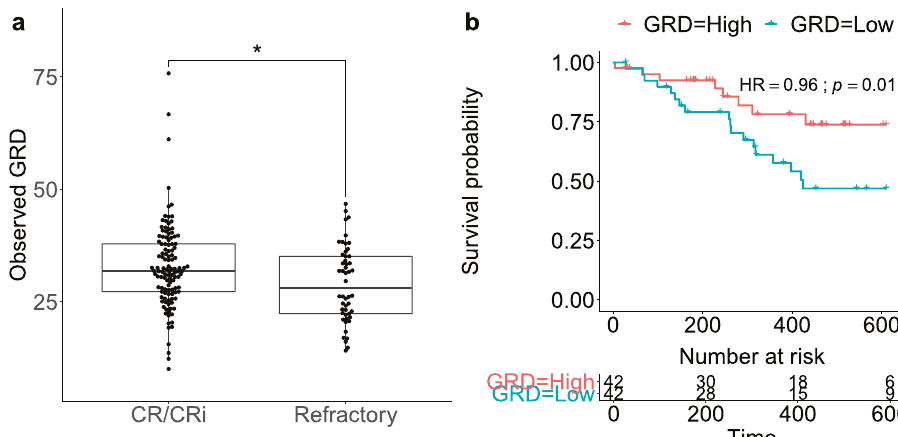
Fig. 2 Ex vivo general response across drugs is associated with clinical response and improved patient outcome. a GRD in patients who achieve complete remission (CR) or complete remission with incomplete hematologic recovery (CRi) to standard induction chemotherapy ( n = 118) versus those refractory to induction ( n = 50) in OHSU dataset. *Wilcoxon rank-sum test p < 0.05. b Kaplan – Meier survival curves of patients in OHSU dataset with GRD above the upper quartile (red; “ responders ” ; n = 42) and of those with GRD below the lower quartile (blue; “ non-responders ” ; n = 42). Data are right censored at 610 days. HR: Cox proportional hazard ratio. a , b GRD is computed across drugs common to OHSU and FIMM